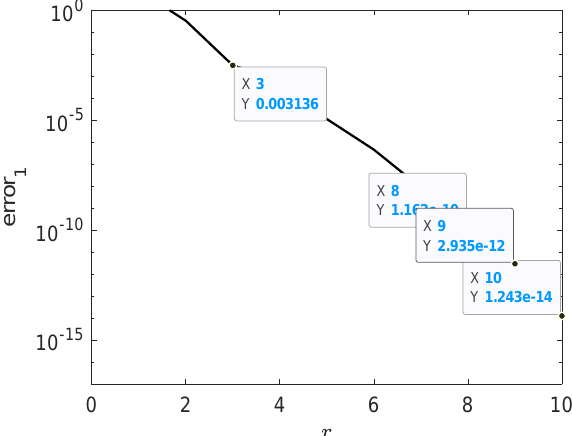
Figure 13. Errors for the Lorenz system.